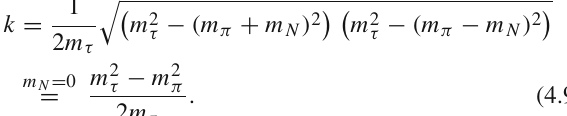
τ τ − α τ qq ) from τ → π and α P = (α qq duNe QuNL LNQd